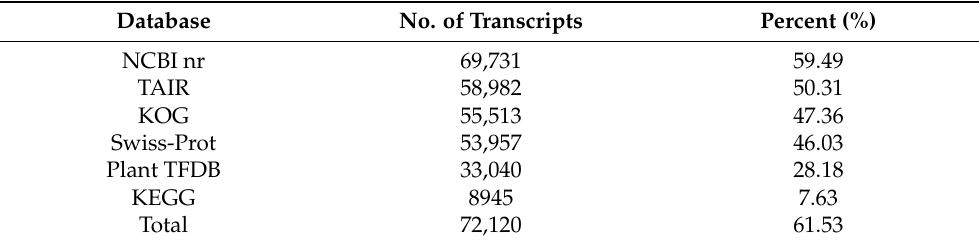
Table 3. Functional annotations of transcripts with various public databases.